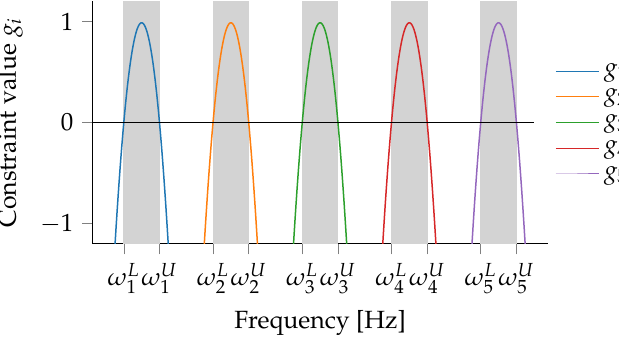
Figure 2. An example of the parabolic formulation for frequency-band constraints where the ranges to be avoided are gray, and each colored line represents a constraint